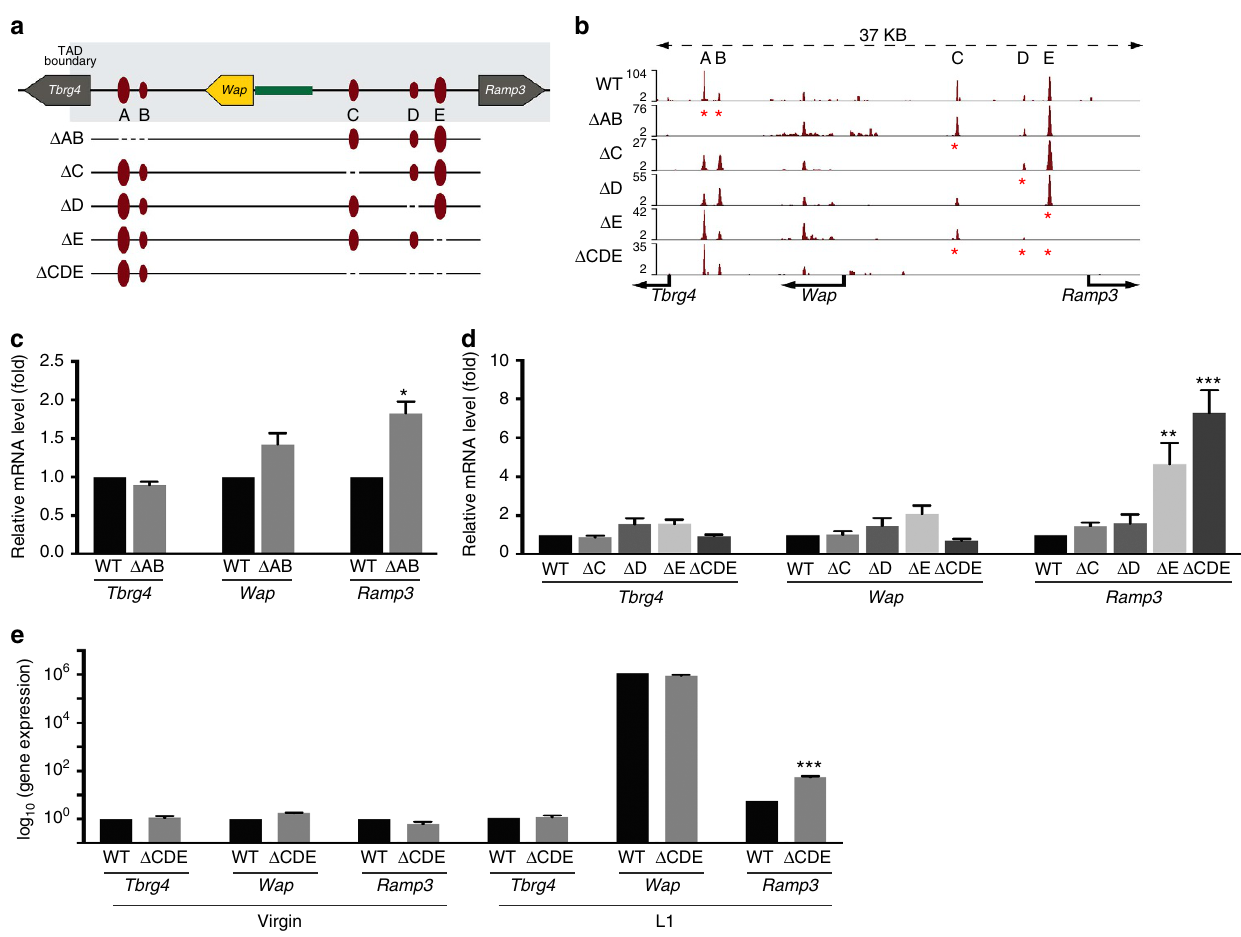
Figure 4 | Deletion of CTCF sites flanking the Wap locus. ( a ) Diagram of the CTCF-binding sites in the Tbrg4-Wap-Ramp3 locus and the deletions investigated. Individual deletions of sites C, D and E and two combined deletions, one comprising sites A and B and one comprising sites C, D and E were generated and analysed. ( b ) CTCF ChIP-seq analyses from mutant tissues confirmed loss of CTCF binding at the respective deleted sites. ( c ) Deletion of sites A and B did not affect expression of Tbrg4 and Wap using qRT–PCR. Results are shown as the means ± s.e.m. of independent biological replicates; D AB n ¼ 4 ( (cid:2) / (cid:2) ); data were normalized to Gapdh ; a two-tailed Student’s t -test was applied with alpha 0.01 for wild type and D AB for each gene these two genes. Loss of sites C or D did not affect gene expression, whereas loss of site E resulted in an approximately five-fold increase in expression of Ramp3 and a seven-fold induction in mice carrying combined deletions of C, D and E. Tbrg4 and Wap did not show changes in gene expression. Results are shown as the means ± s.e.m. of independent biological replicates; D C n ¼ 10 ( (cid:2) / (cid:2) ); D D n ¼ 5 ( (cid:2) / (cid:2) ); D E n ¼ 7 ( (cid:2) / (cid:2) ); D CDE: n ¼ 4 ( (cid:2) / (cid:2) );